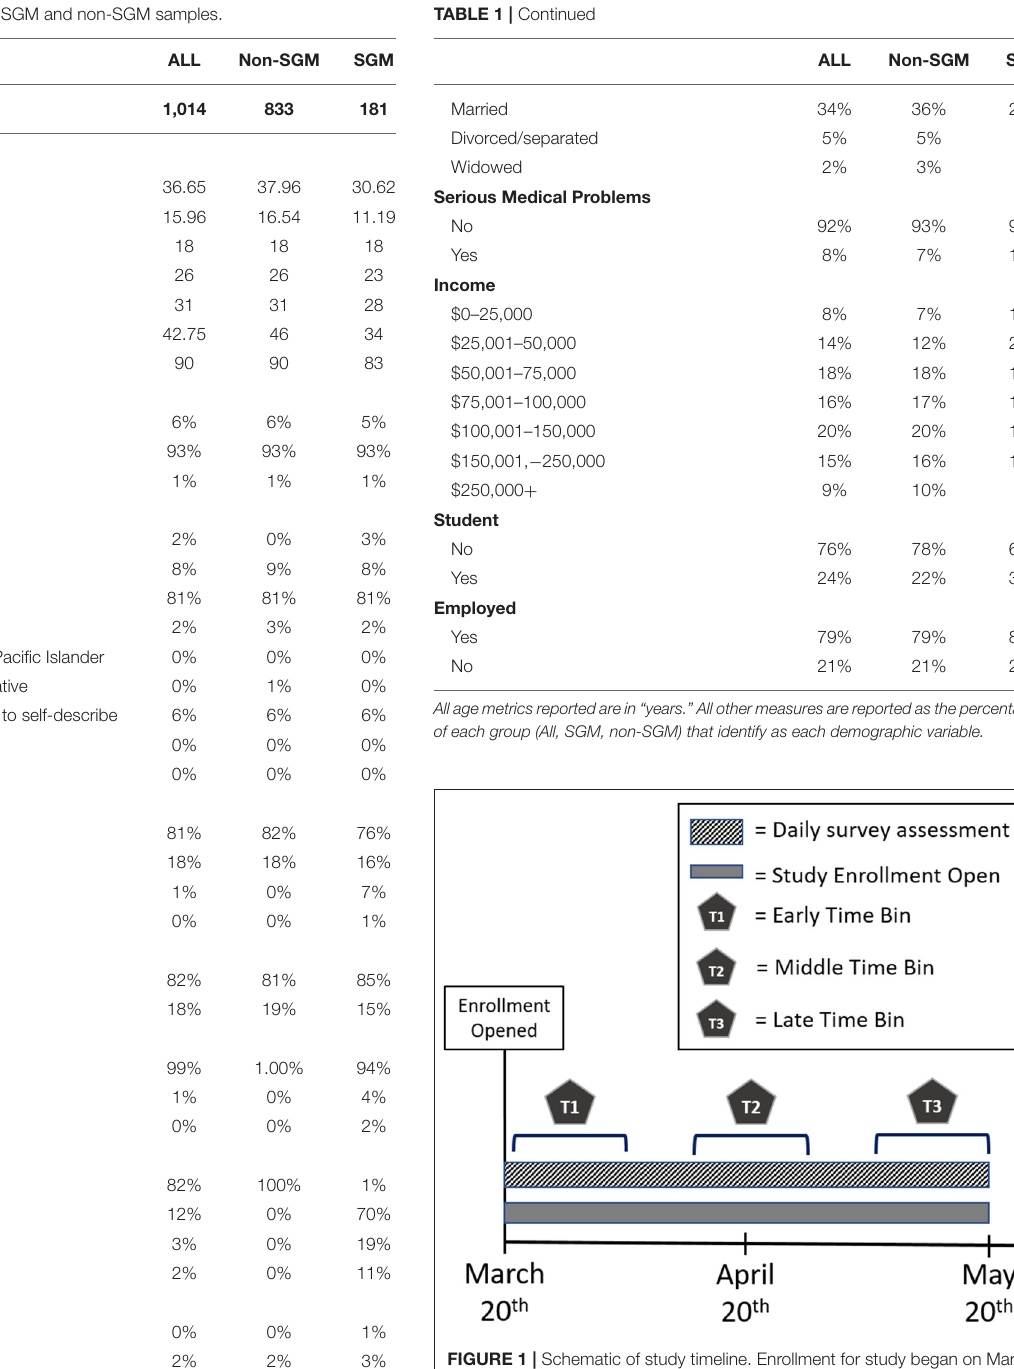
FIGURE 1 | Schematic of study timeline. Enrollment for study began on March 20, 2020. Daily surveys were collected from March 21, 2020 to May 20, 2020. For analyses, we separated the timeline into three separate time bins. Early Time bin (T1) = March 21st–April 3rd; Middle Time bin (T2) = April 14th–April 27th; Late Time bin = May 7th–May 20th.